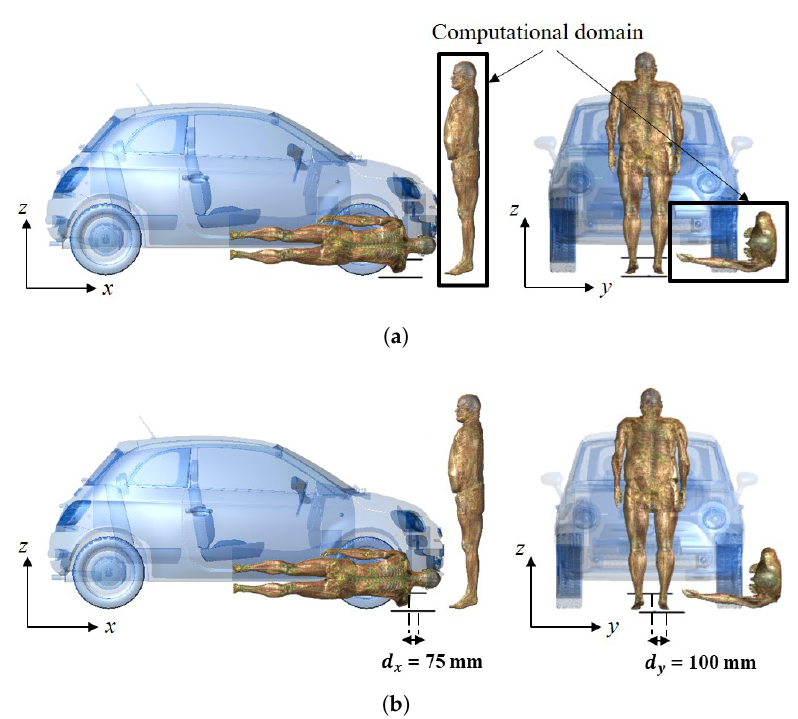
Figure 2. Exposure scenario #2: Duke lying on the ground floor and Fats standing in front of the car for the aligned ( a ) and misaligned ( b ) coils.